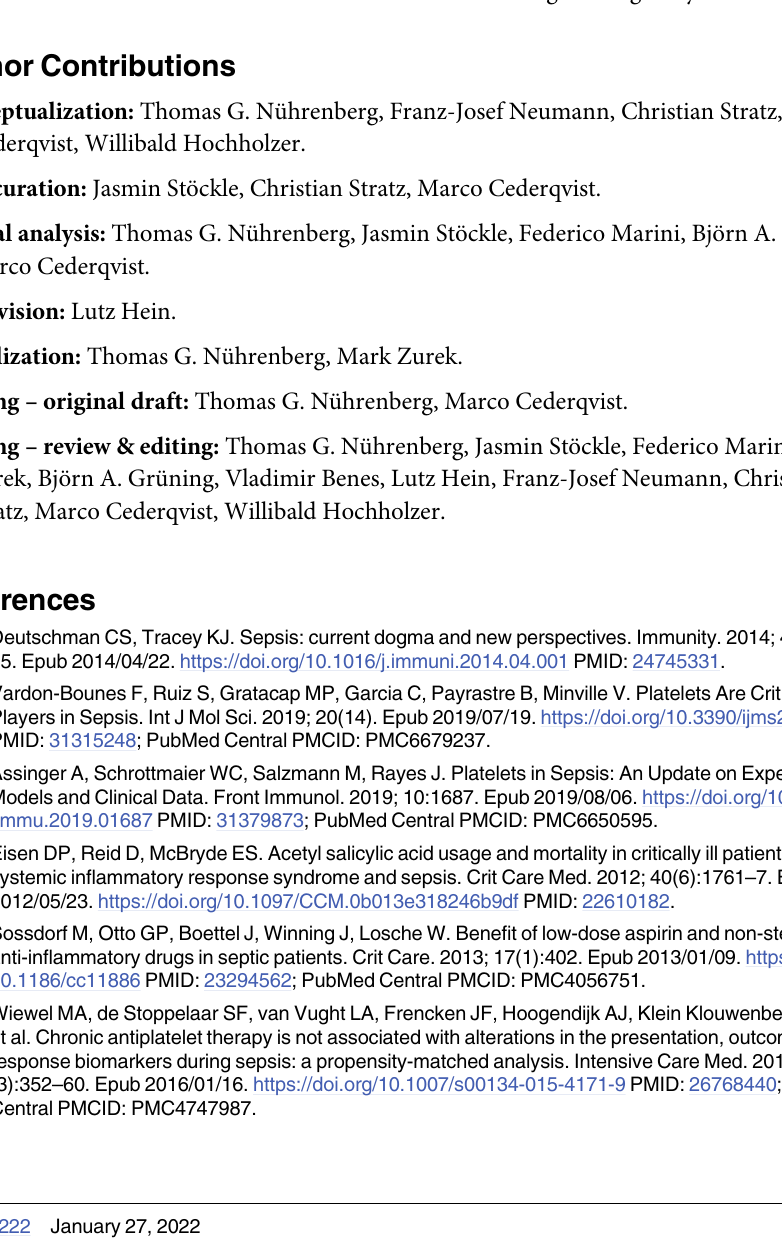
S1 Table. Results from Gene Set Enrichment Analysis for pre-defined gene sets related to platelet activation and platelet inhibition. Results from Gene Set Enrichment Analysis for 29 gene sets retrieved from Molecular Signature Database related to platelet activation or platelet inhibition, according to [23], for possible enrichment in platelets from patients with sepsis. S2 Table. Results from DeSeq2 including normalised counts for individual samples. Sheet ‘all transcripts’ depicts DeSeq2 results and normalised counts for all annotated transcripts. Sheet ‘differentially exp transcripts’ depicts DeSeq2 results and normalised counts for tran- scripts with adjusted p value < 0.05 and FC >